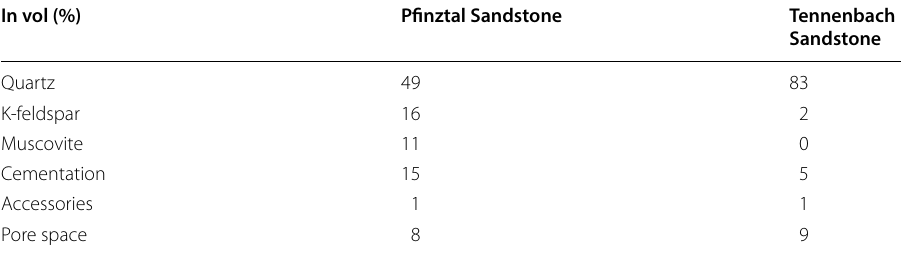
Table 1 Mineral composition of the two sandstone variations Pfinztal Sandstone and Tennenbach Sandstone used in the triaxial tests (Schmidt et al. 2017) In vol